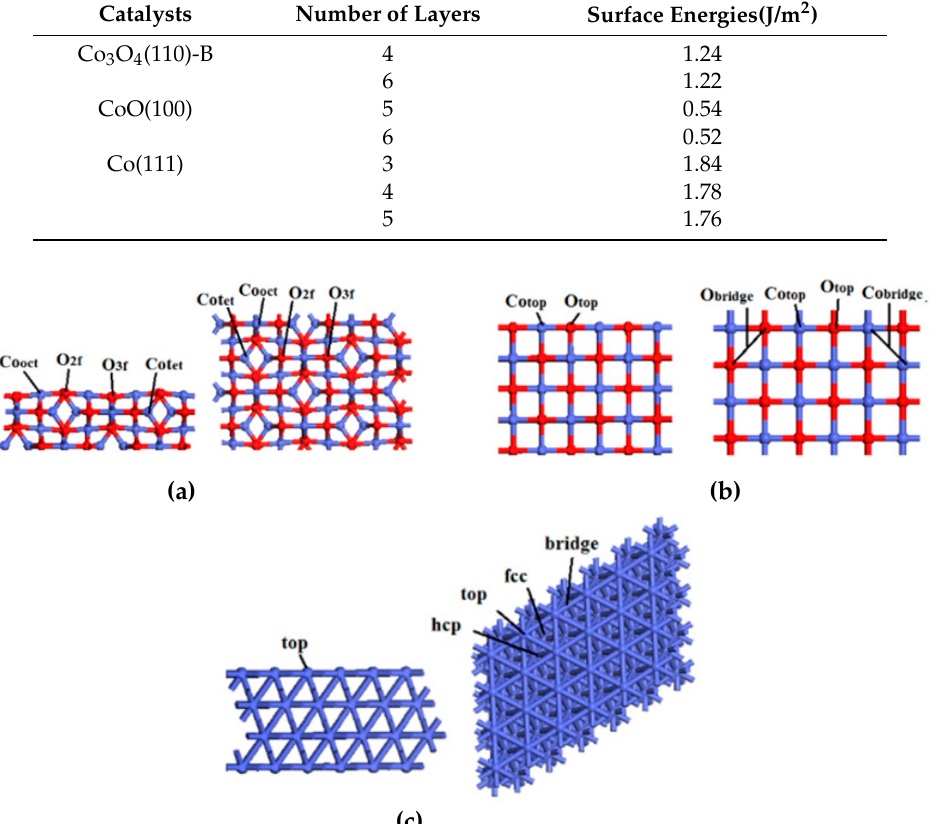
Table 2. The surface energies of Co 3 O 4 (110)-B, CoO(100) and Co(111) surfaces. Catalysts Number of Layers